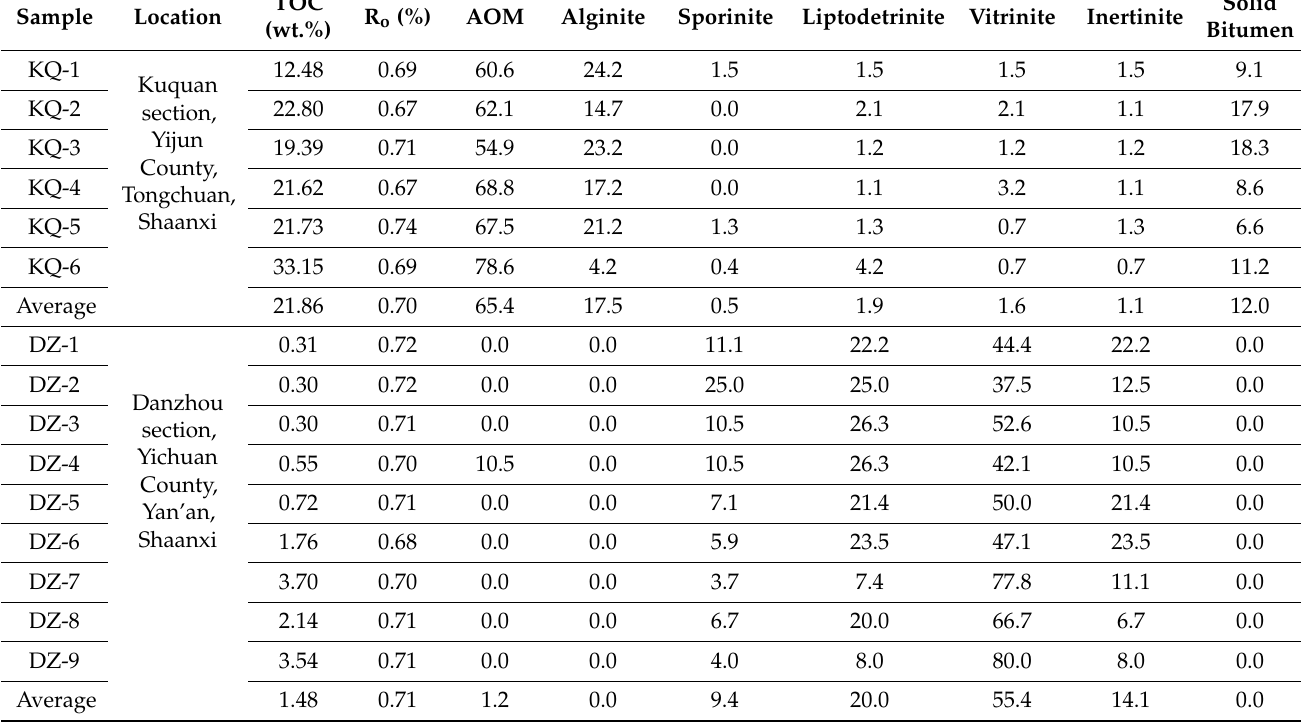
Table 1. Total organic carbon (TOC) content, vitrinite reflectance (R o ), and maceral composition (vol.%; on mineral-free basis) of the studied Chang 7 Member shale